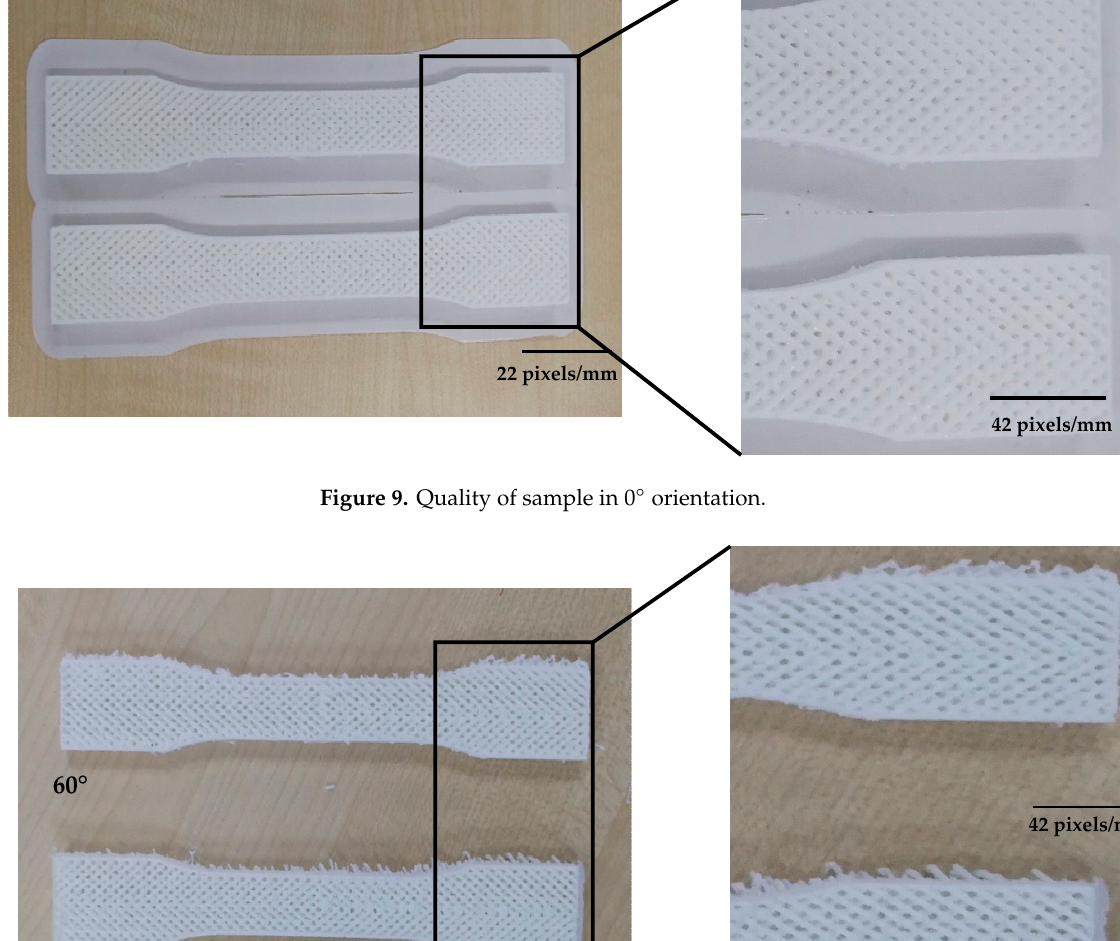
Figure 11. Defect in 75° flat samples.